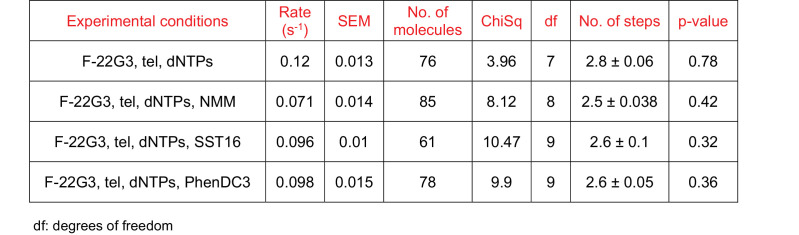
Curve fitting parameters of the curves in Figure 7K.